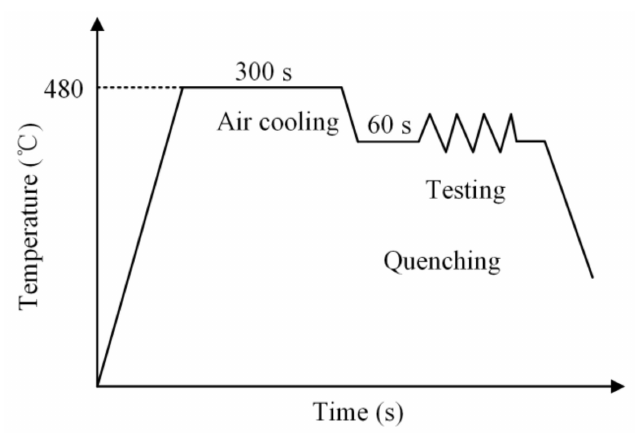
Figure 4. Schematic diagram of the hot tensile